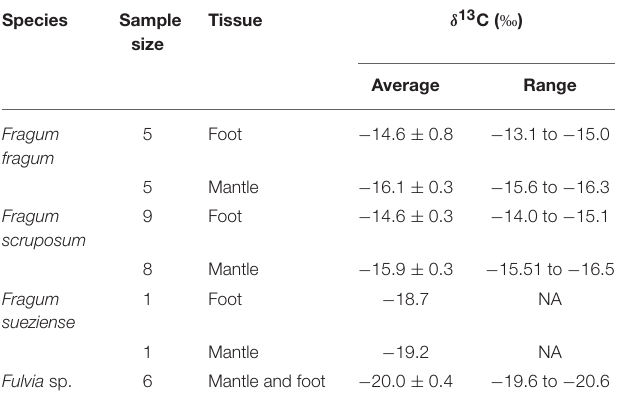
TABLE 4 | Tissue δ 13 C values of Fragum fragum , F. scruposum, F. sueziense, and the filter-feeing Fulvia sp. Species